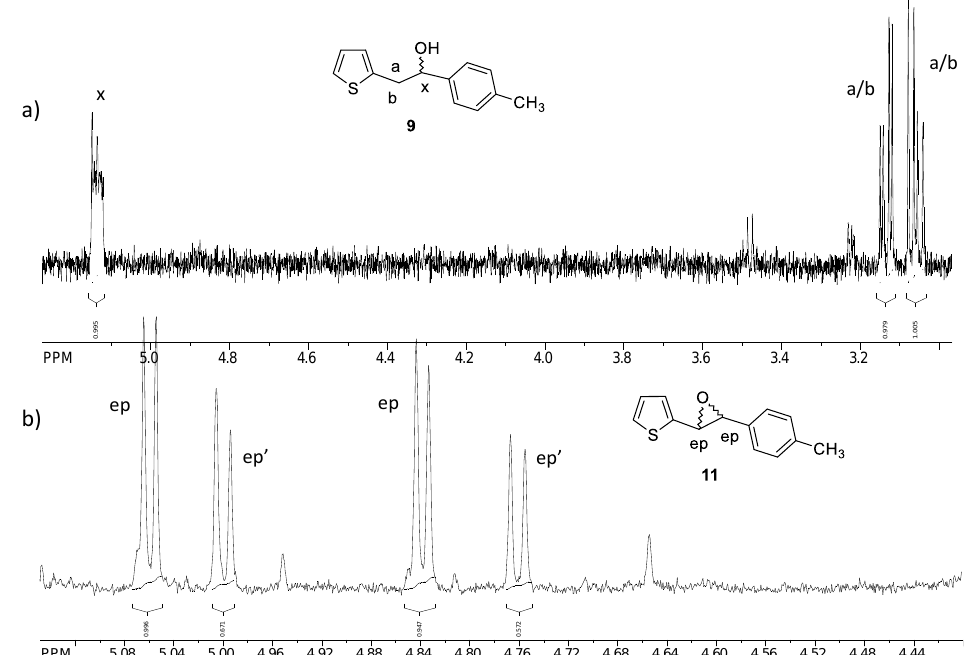
Figure 8. Aliphatic parts of 1 H NMR spectra (CDCl 3 ) of hydroxy ABX system in product 9 ( a ) and epoxy derivative 11 ( b ), as mixture of diastereomers in the ratio 1:1.5 with characteristic patterns for assignation of the specific structures.